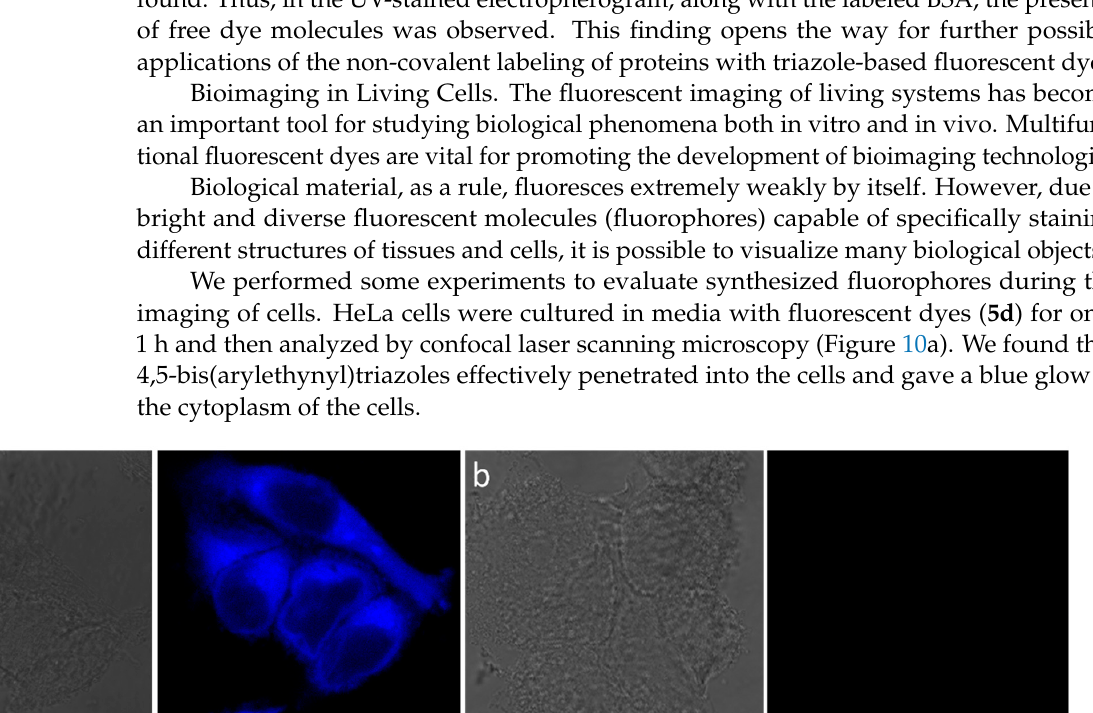
Figure 9. Electropherograms with native BSA and BSA labelled with dye 8a stained under UV ( A ) ( A ) and using a protein staining dye ( B ). and using a protein staining dye ( B ).